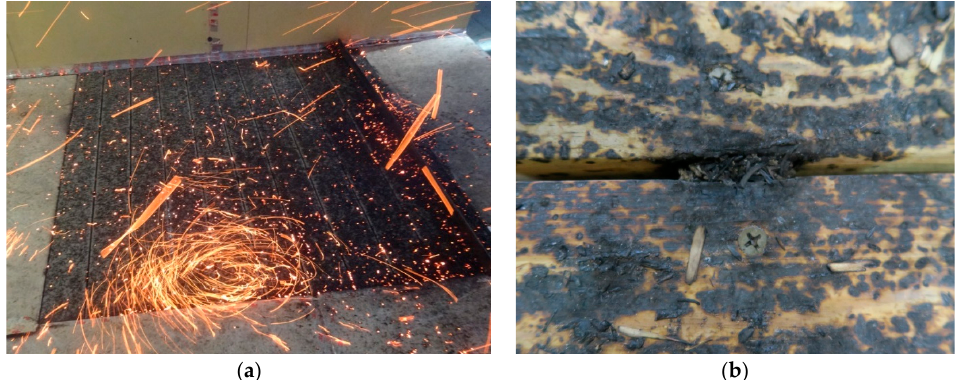
Figure 8. ( a ) The patterns on the deck resulted in embers dropping into gaps between deck boards. ( b ) The embers accumulated in the gaps between deck boards on top of the joist.